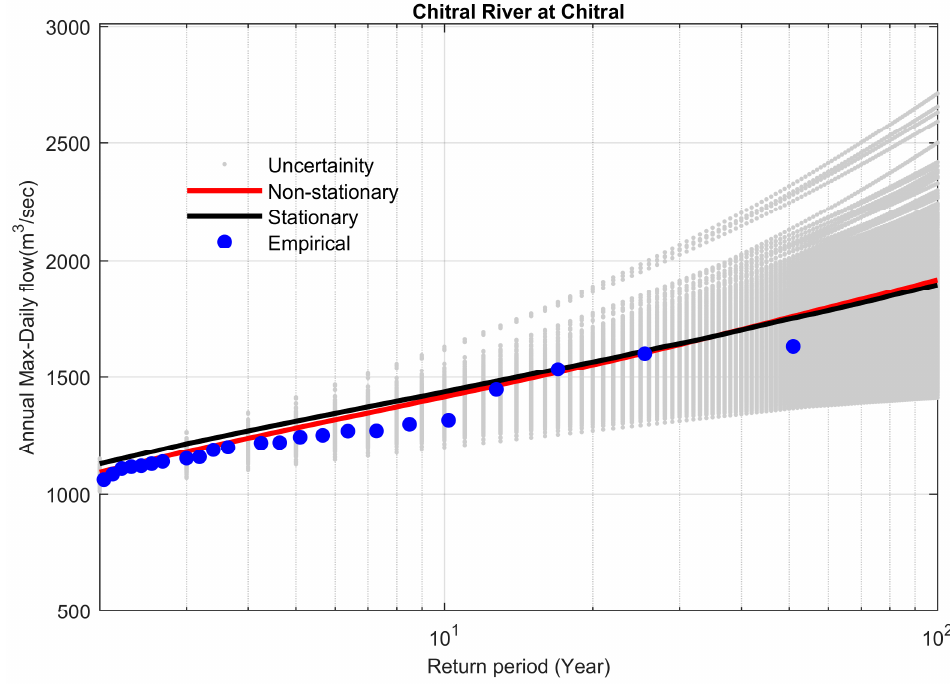
Figure 9. Comparison between non-stationary and stationary FFCs at site 6, along with non-stationary uncertainty bounds for the year 2013.